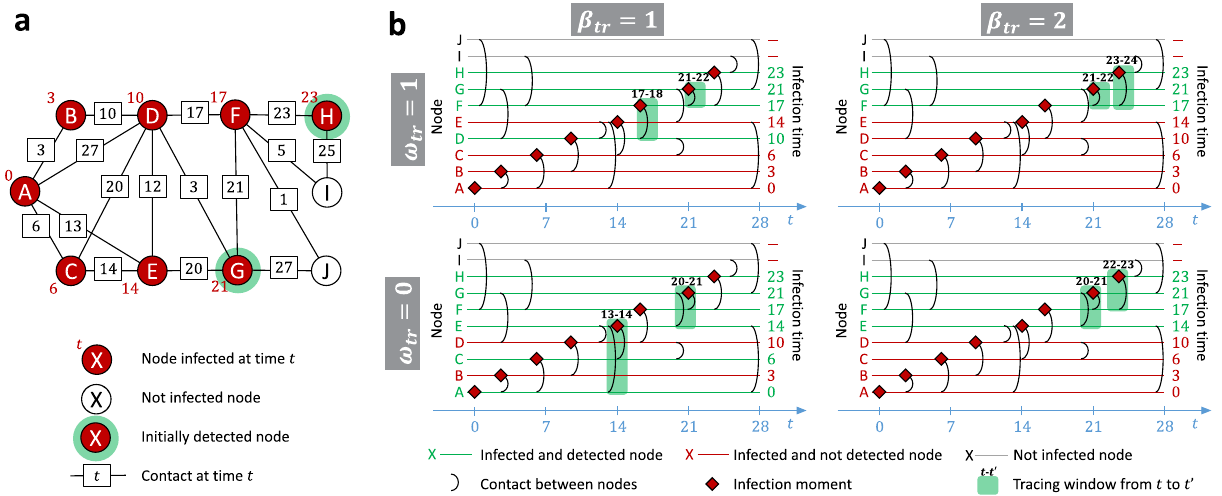
Figure 1. Examples of the tracing process for different values of tracing breadth β tr and tracing window offset ω tr . Panel ( a ) presents a temporal network at the end of the infection process started from the node A . Red numbers next to the nodes represent infection times, white nodes did not get infected. Numbers on the edges represent contact times. At the beginning of the tracing process only the nodes with green rim are detected. Panel ( b ) presents the results of the tracing process for varying β tr and ω tr , with tracing budget b = 2 , and tracing window size δ = 2 . In every plot horizontal lines represent nodes, with red lines corresponding to infected nodes that did not get detected, green lines to detected infected nodes, and black lines to nodes that did not get infected. Black arcs between lines indicate contacts, with time of the contact represented by the position on the x-axis of the plot. Red rhombuses indicate infection times of the nodes. Green rectangles indicate windows in which contacts of different nodes got traced for the given values of β tr and ω tr